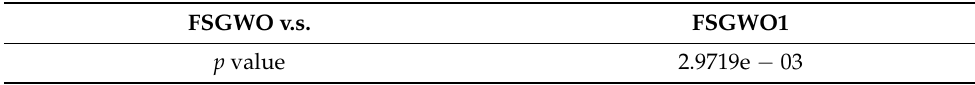
Table 11. Results of the Wilcoxon test for the mean values of Table